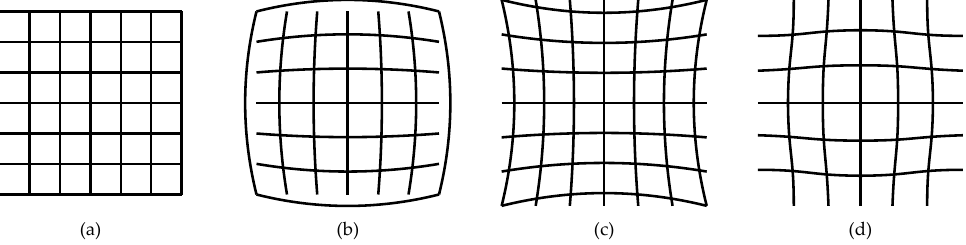
Figure 13. Distortions that lenses can produce ( a ) Without distortion. ( b ) Barrel distortion. ( c ) Cushion distortion. ( d ) Complex distortion.